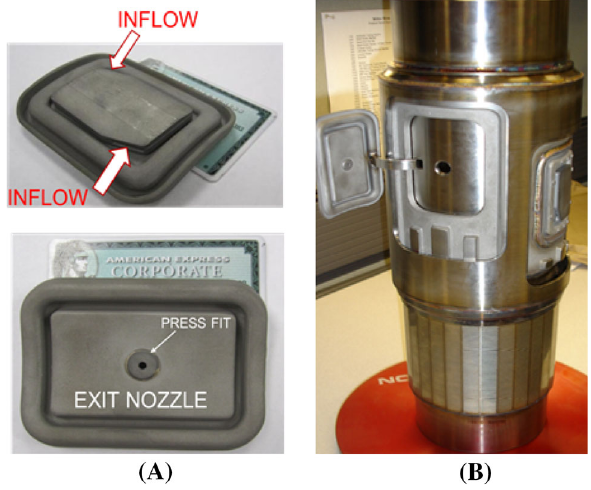
Fig. 5 Fluid flow path (from reservoir to base pipe) through a fluidic diode FCD installed for production